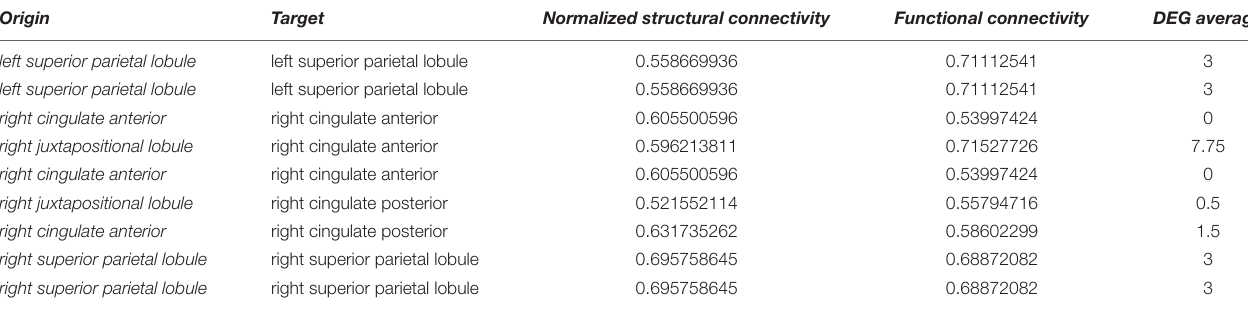
TABLE 3 | Strong connectivity and high similarity in gene